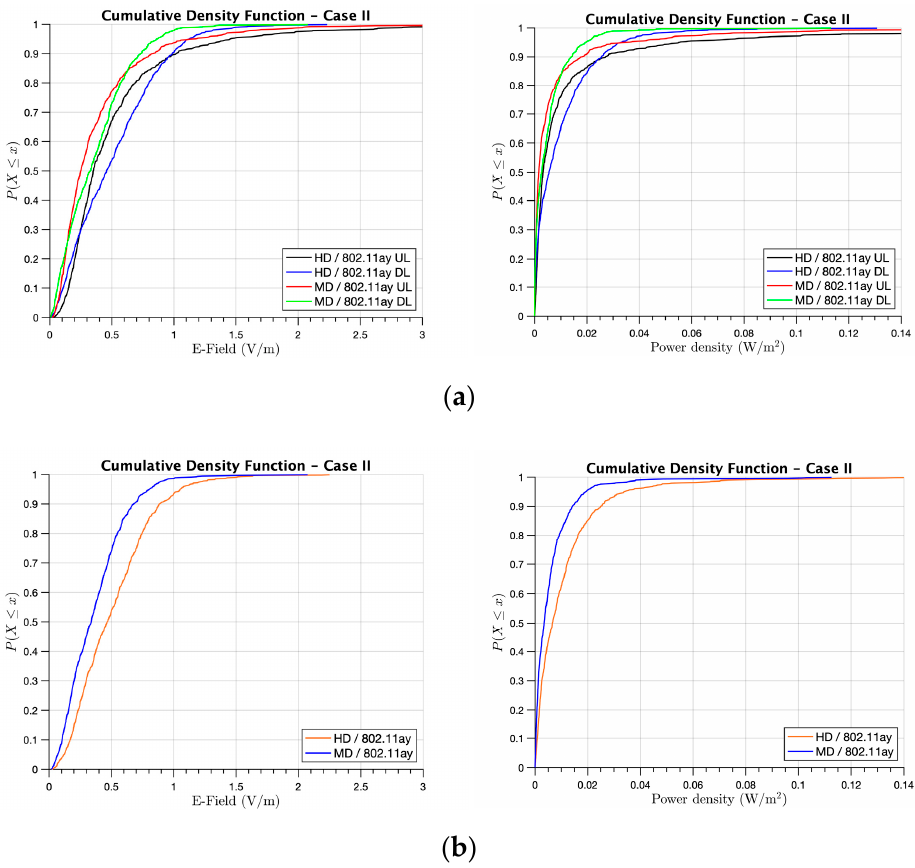
Figure 11. CDF of the received E-field and Power density for Case II at the XY bi-dimensional plane at head height when the people were working on the first floor of the library: ( a ) UL and DL comparison for HD and MD and ( b ) the total E-field exposure and power density for HD and